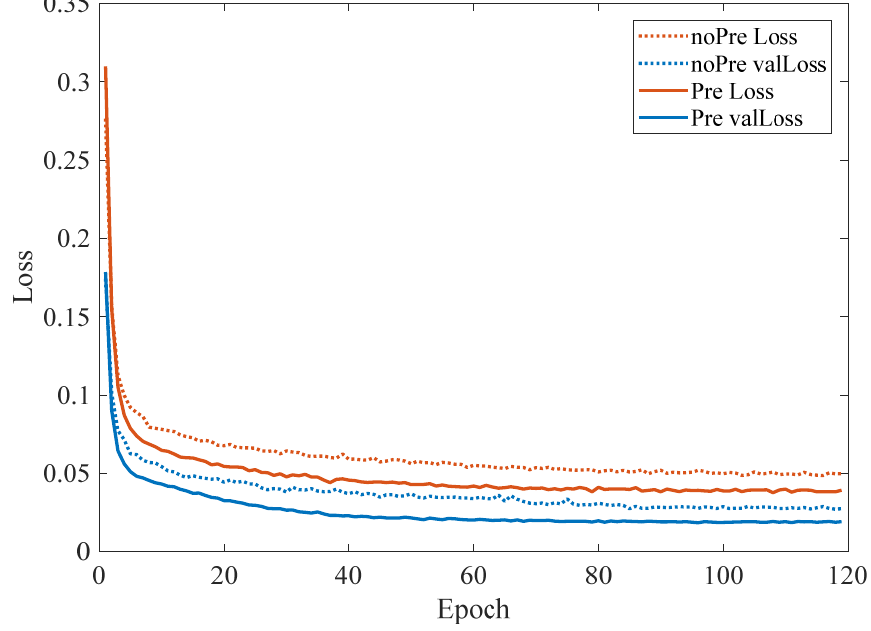
Figure 7. Big coal block dataset training loss curve.